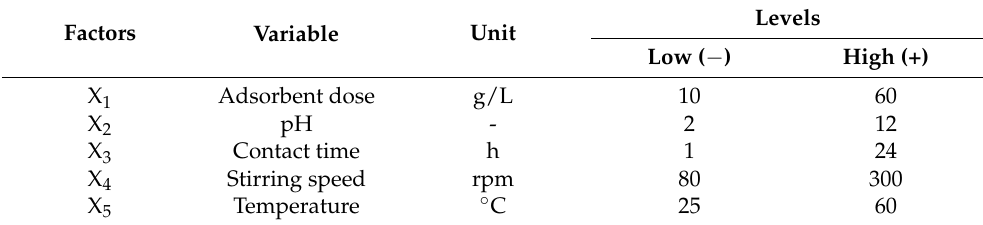
Table 1. Process factors and their levels.